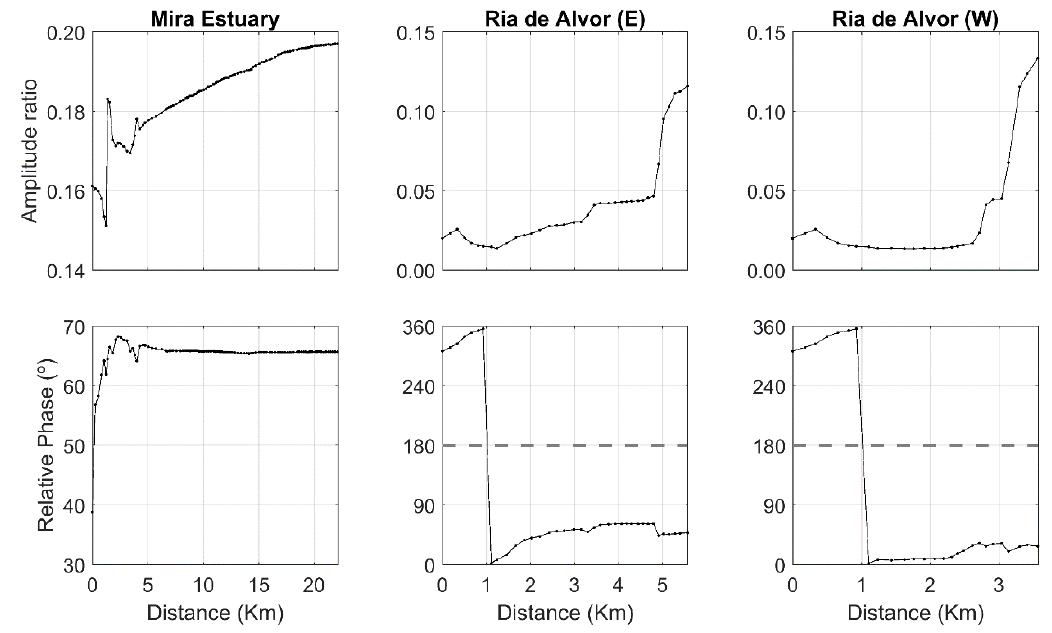
Figure 4. Amplitude ratio and relative phase ( ◦ ) throughout the axis of the Mira and Ria de Alvor channels (see Figure 1).